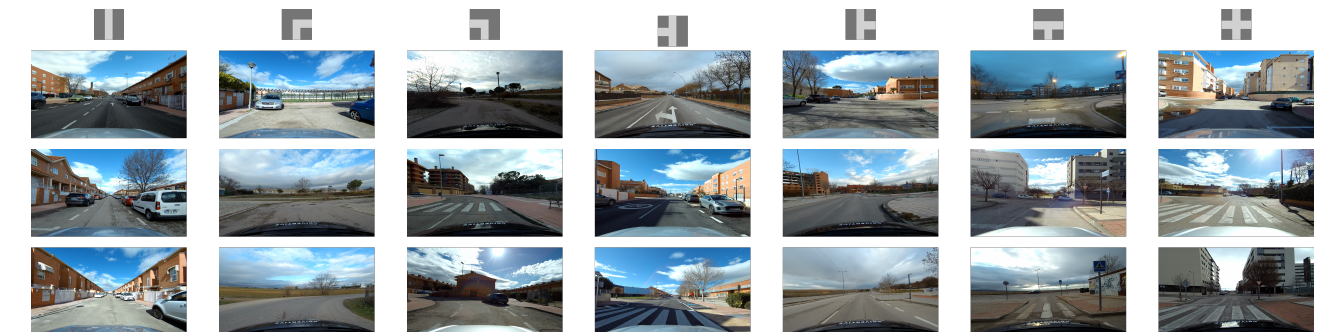
Figure 5. Each column shows three examples of the seven configuration geometries that were used in this work (with the so-called canonical images shown in the upper part of each column). The RGB examples come from our recorded dataset. We recorded the images at different times of the day using a different camera setup for more than 3:30 h of recording time, including more than 500 intersections.